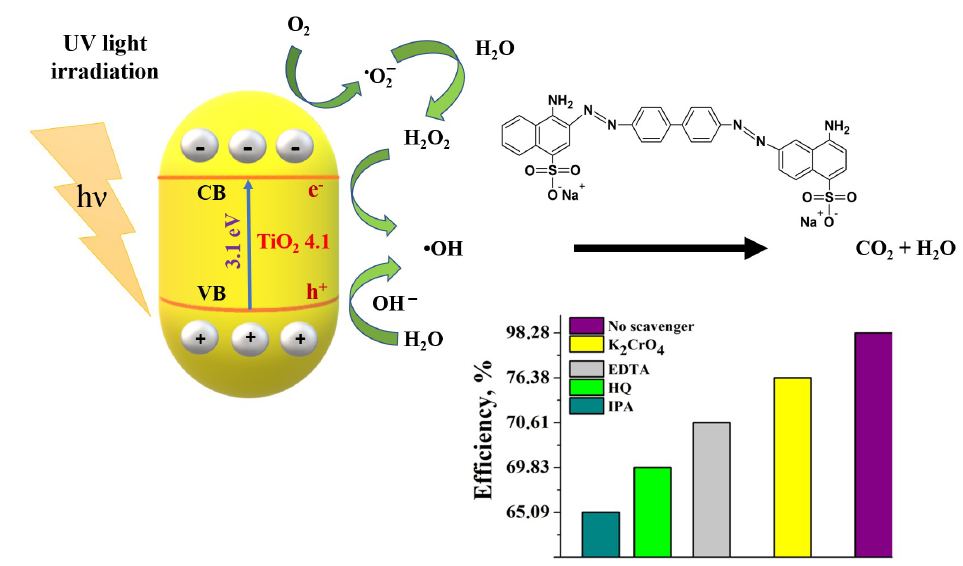
Figure 9. Schematic illustration of CR dye photodegradation mechanism onto TiO 2 4.1 titania sample and effect of various scavengers on its efficiency.